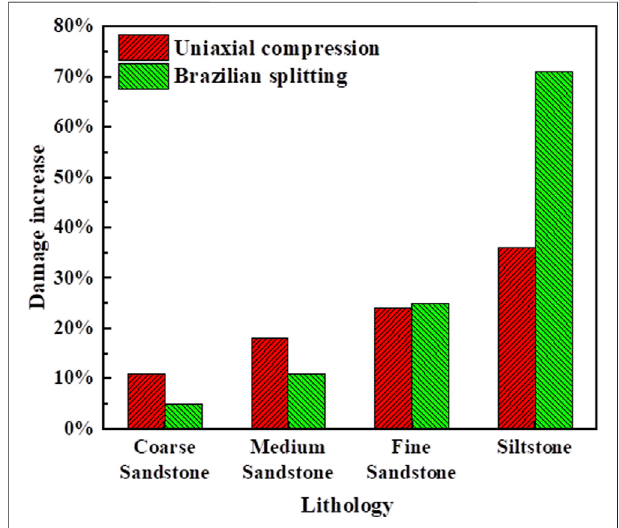
FIGURE 9 | Distribution of damage increase for typical sandstone with different grain